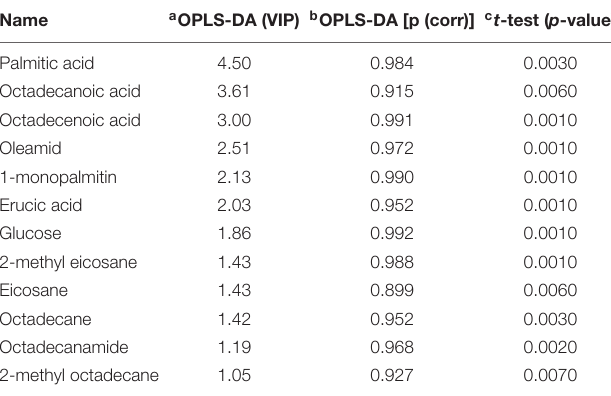
TABLE 2 | Metabolite markers that best explain the variance between the individually cultured samples in the absence and presence of DHA-CS NPs. Name